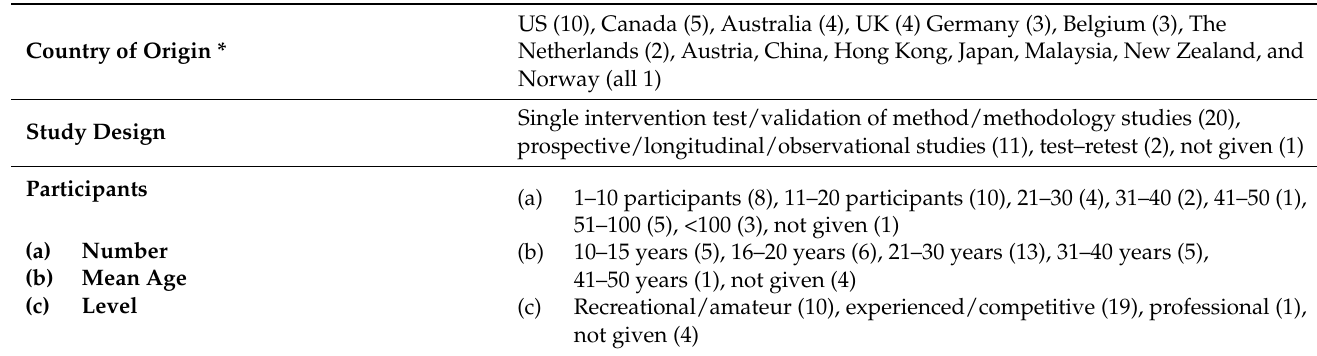
Table 2. Excerpt of demographic and technological characteristics of all included studies ( n =